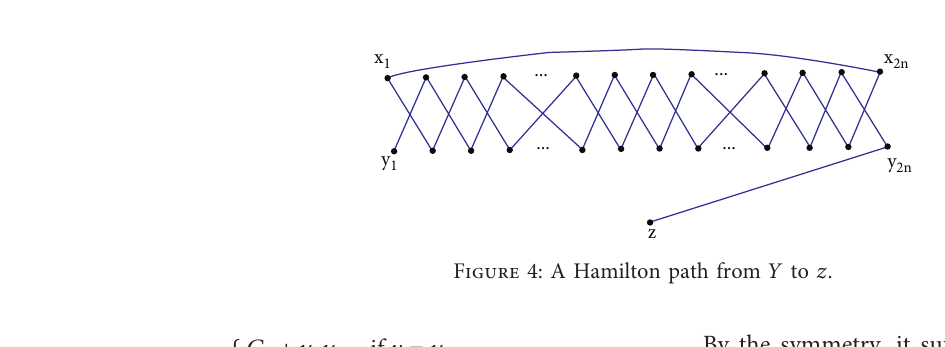
Figure 3: A Hamilton path from A to B .